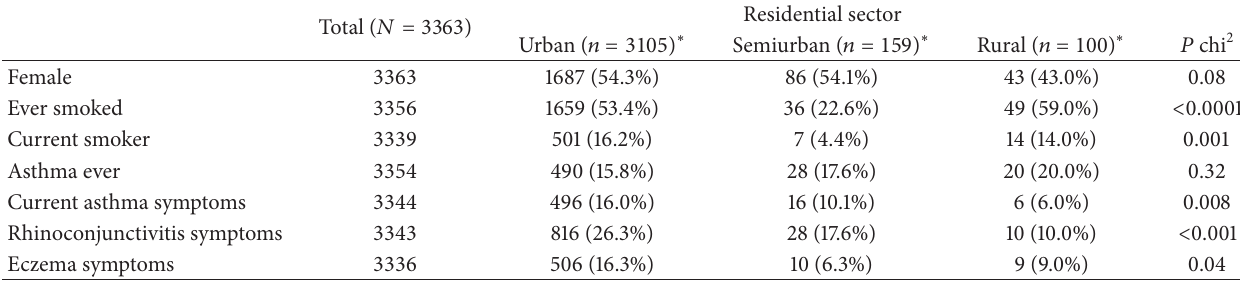
Table 1: Description and symptoms prevalence stratified by residential sector.